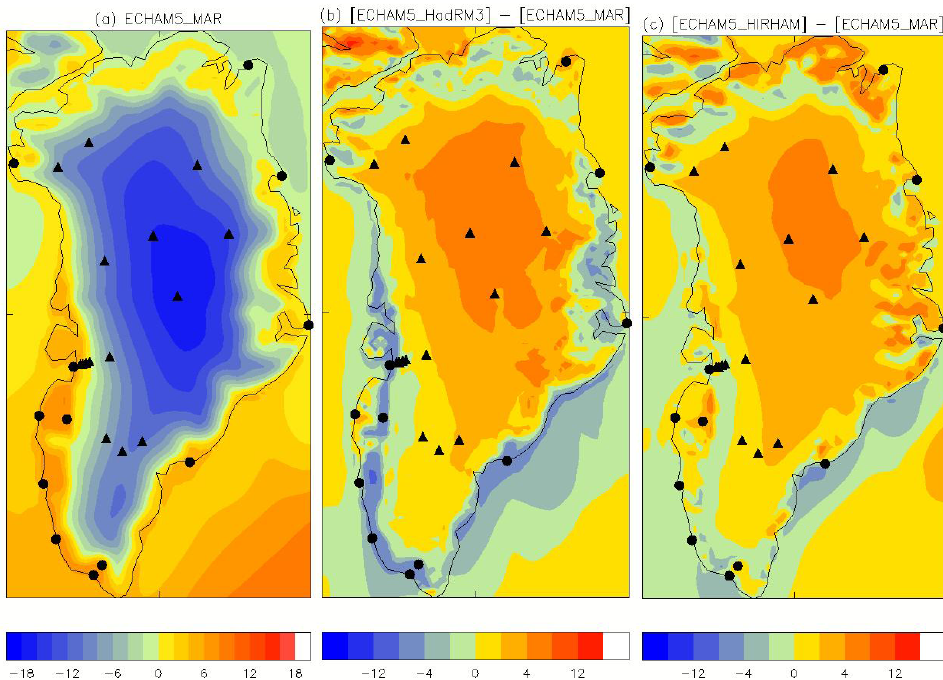
Fig. 3. 20-yr mean near-surface air temperatures ( T as ) for 1980–1999. (a) ECHAM5-forced MAR. (b) Difference between ECHAM5-forced HadRM3P and ECHAM5-forced MAR. (c) Difference between ECHAM5-forced HIRHAM5 and ECHAM5-forced MAR. Scale in (b) and (c) is different from that in (a) . Observing stations used in the T as evaluation (Fig. 2) are also shown (circles for DMI stations, triangles for GC-Net